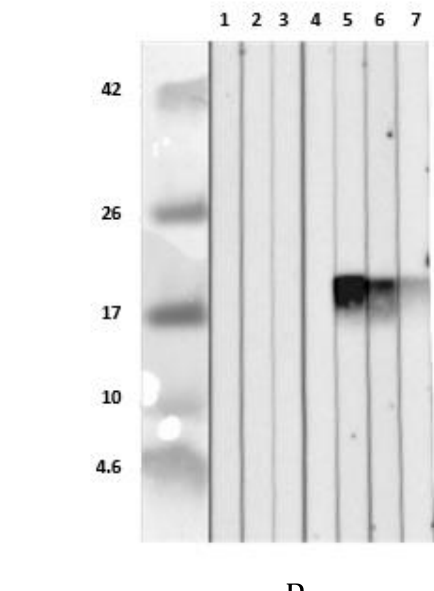
Figure 4. ( A ) Immunoblot with naturally purified L. luteus LTP; ( B ) with naturally purified L. angustifolius LTP, using in a first step Synblock, in a second step anti-human-IgG 1:500. The sera were diluted 1:10. (1) Tris control; (2) negative control serum; (3) lupine and peanut allergy (P 6); (4) peanut allergy, lupine-sensitized (P 9); (5) peanut allergy, lupine-sensitized (P 5); (6) peanut allergy, lupine-sensitized (P 4); (7) peanut allergy and suspected lupine allergy (P 3); (8) peanut and suspected lupine allergy (P 2); (9) peanut and lupine sensitization (P 1); (10) lupine allergy and peanut sensitization (P 8); (11) lupine and peanut allergy (P 7). ( C ) SDS-PAGE for MS-analysis: L. angustifolius LTP (1) and L. luteus LTP (2) under reducing conditions. L. angustifolius LTP (3) and L. luteus LTP (4) under non-reducing conditions. ( D ) Immunoblot with natural L. angustifolius LTP (non-reducing conditions) (1) Tris (2nd antibody control) (2) negative serum I (3) negative serum II (4) negative serum III (5) peanut allergy and lupine-sensitized (P 4); (6) peanut allergy and lupine-sensitized (P 9); (7) lupine and peanut allergy (P 6). (P-codes refer to Table 1).